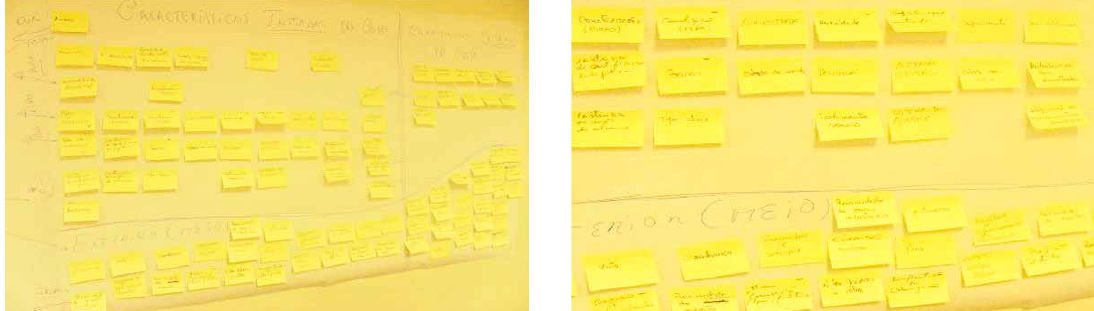
Fig. 4. Snapshots of the “post-its session” [3 rd